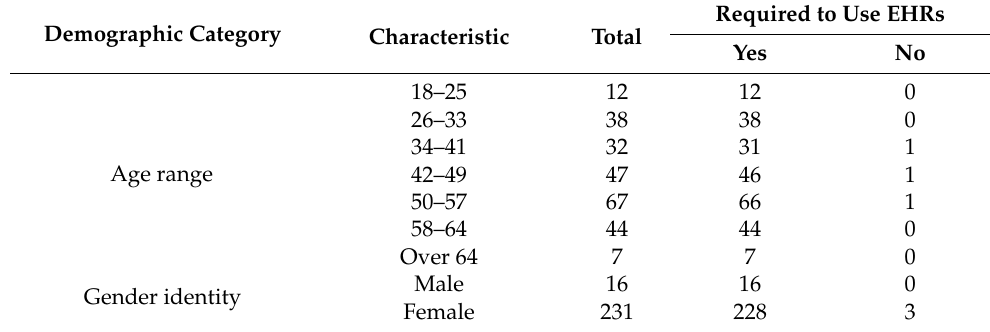
Table 2. Sample descriptive